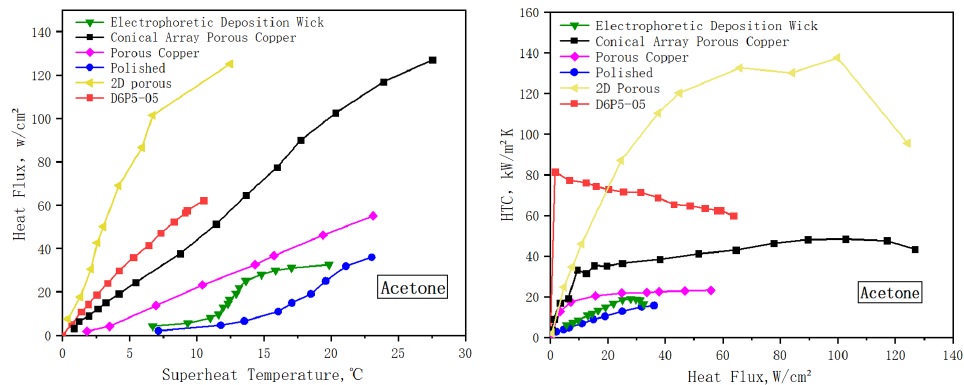
Figure 12. Comparison of heat transfer performance.